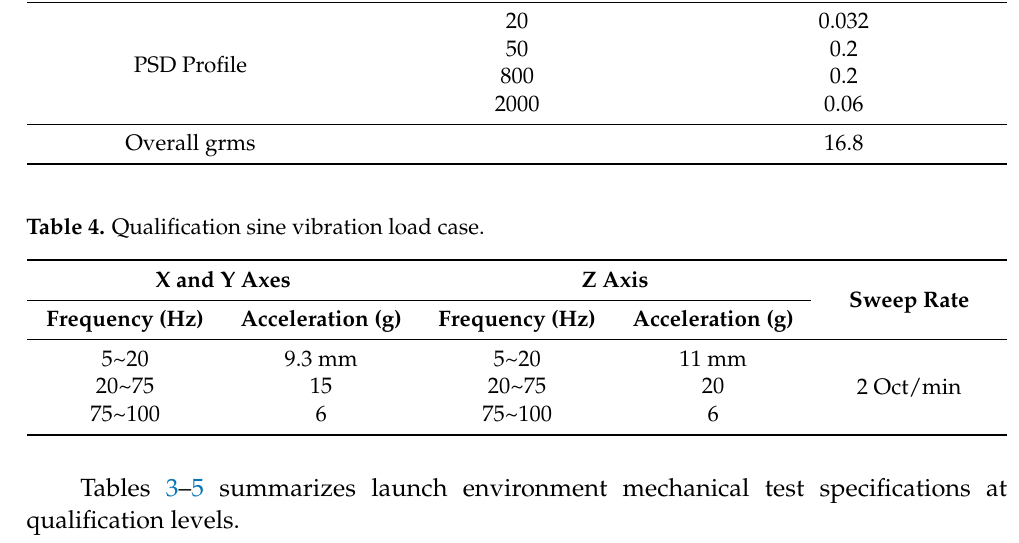
Table 5. Qualification shock load case. Table Spectrum